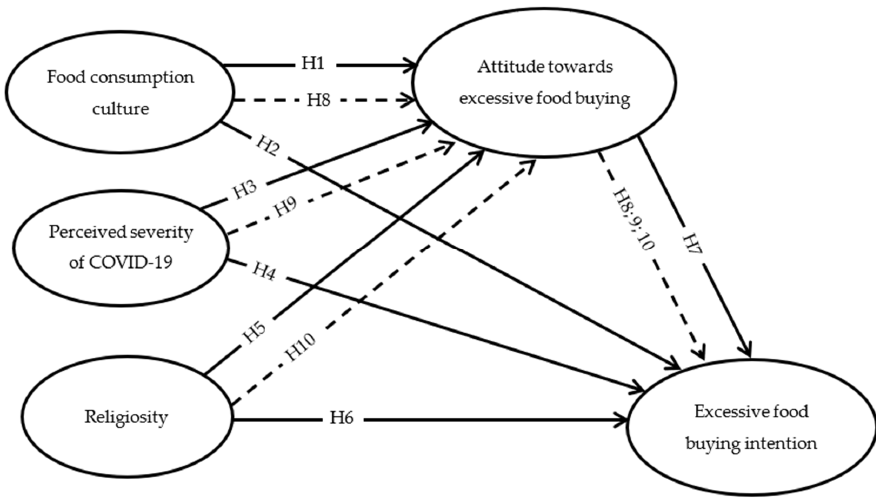
Figure 1. Effects of food consumption, perceived severity, religiosity, and attitude on excessive food- buying